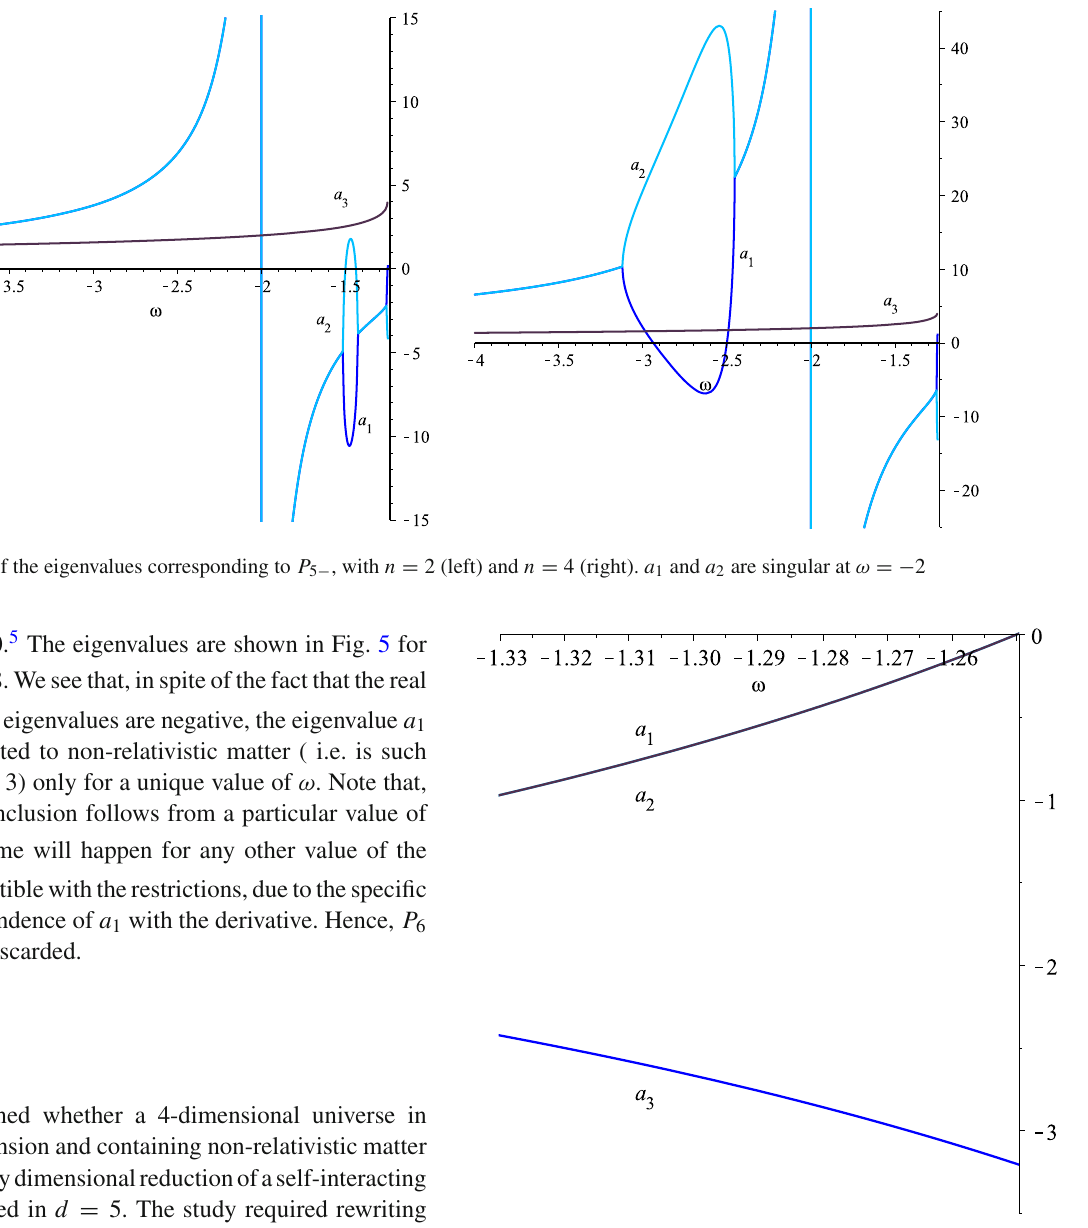
Fig. 5 Plot of the real parts of the eigenvalues corresponding to P 6 , (cid:18) (cid:18) = − 1 . 8 (cid:18) for d Γ(λ) d λ λ c